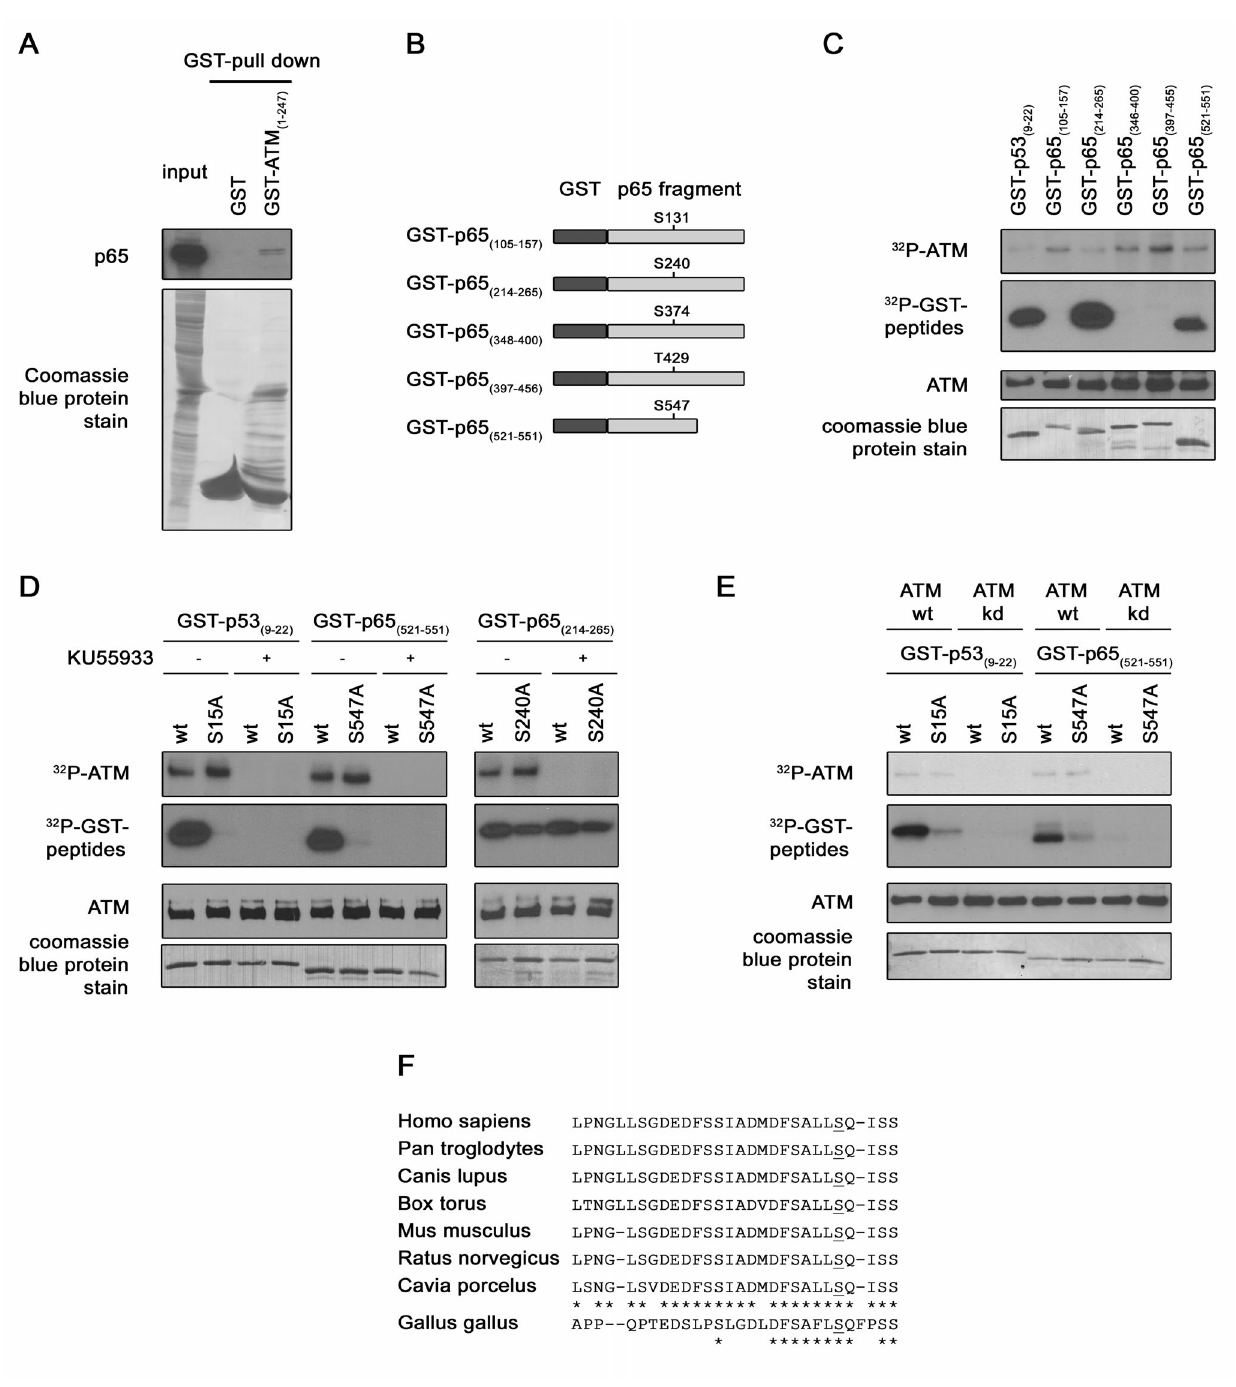
Figure 1. p65 interaction with ATM and p65 Ser 547 phosphorylation by ATM. ( A ) Confirmation of a direct interaction between ATM and p65. Bacterially expressed GST or GST-ATM (1–247) fusion protein were purified on glutathione agarose beads and used to pull-down p65 from HEK- 293 over-expressing HA-p65 cell lysate. Pulled down p65 was detected by immunoblotting with a p65 antibody (upper panel) and GST proteins were stained with coomassie bleu on the PVDF membrane. ( B ) Identification of the ATM target residue. Schematic representation of the different GST-p65 substrates used in the kinase assay. ( C ) In vitro kinase assay. Immunoprecipitated ATM from HEK-293 cells was incubated with GST-p53 and different GST-p65 proteins in presence of [ c 2 32 P]ATP. The radiolabelled bands (upper panels) represent auto-phosphorylated ATM, phosphorylated GST-p53 or GST-p65. Levels of ATM and of substrate present in each reaction were determined by western blotting and by coomassie blue staining respectively (lower panels). ( D ) As in (C) In vitro kinase assay but with wt or mutated GST-p53 and GST-p65 proteins as substrates. ATM inhibitor KU55933 was added in some reaction samples as indicated. The same detection methodology than in ( C ) was used. ( E ) As in (D) in vitro kinase assay, but with purified recombinant ATM wt or kd instead of immunoprecipitated ATM and KU55933 utilization. ( F ) Conservation of Ser 547 among different species. Alignment of p65 C-terminal sequence from different mammalian and bird species.